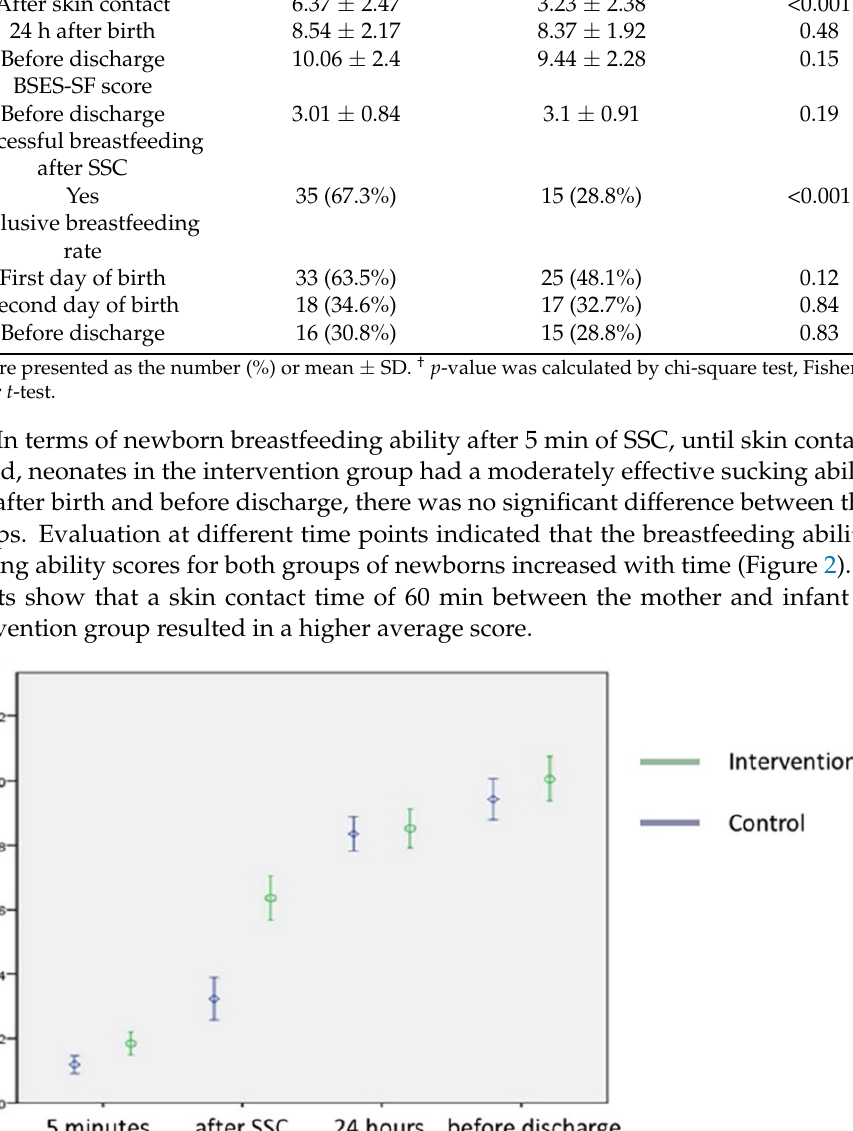
Table 3. Assessment of newborn sucking ability, breastfeeding self-efficacy, and exclusive breastfeed- ing rate.